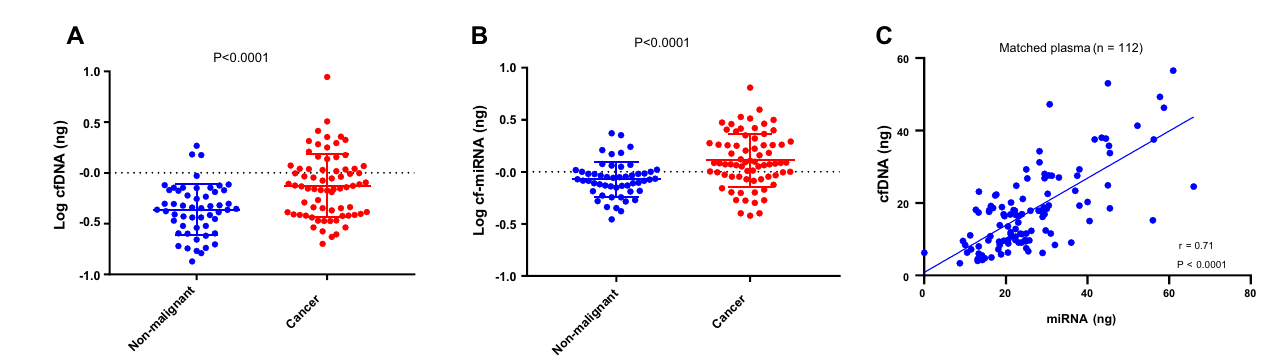
Figure 2. Circulating cfDNA and cf-miRNAs are upregulated in OC. Total cfDNA and cf-miRNAs were measured in plasma. Dot plots depict the total levels (log transformed) of cfDNA ( A ) and cf-miRNAs ( B ) in a group of healthy controls and patients with benign lesions (non-malignant) and OC cases. Significance is calculated by a Mann Whitney